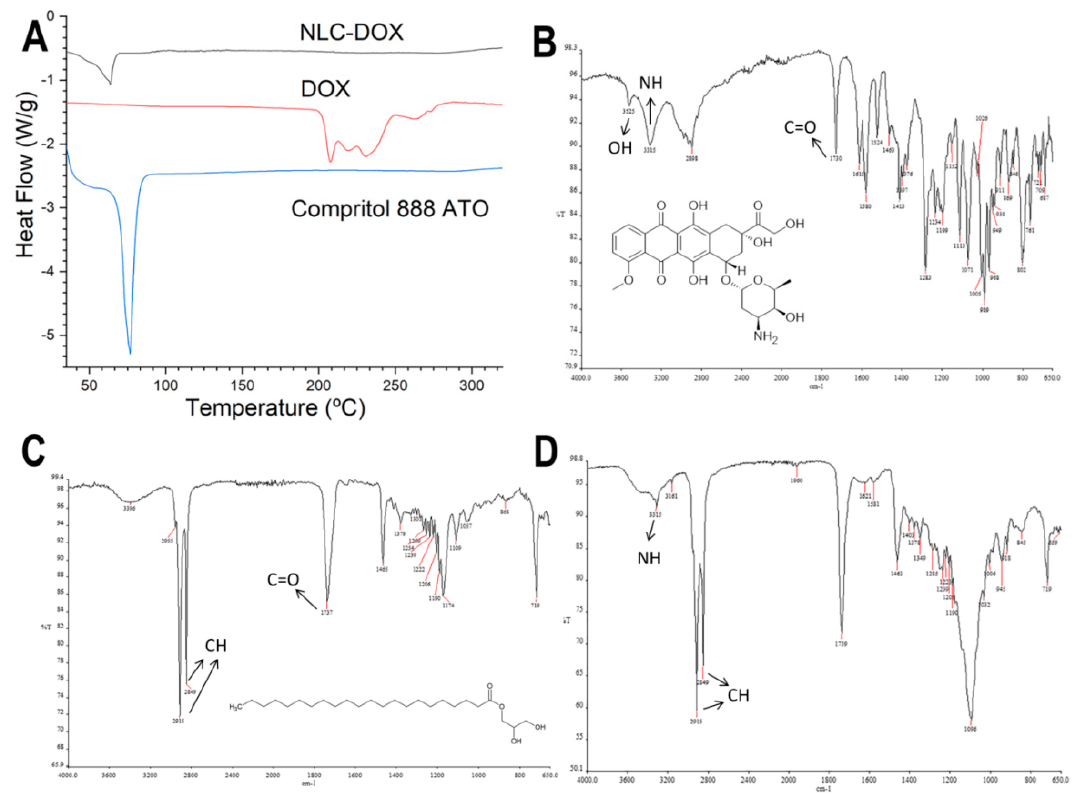
Figure 2. Characterization of the NLC-DOX formulation and its main components by differential scanning calorimetry (DSC) and attenuated total reflection–Fourier transform infrared (ATR-FTIR). DSC curves of NLC-DOX, pure DOX and Compritol 888 ATO ® ( A ); ATR-FTIT spectra of DOX ( B ), Compritol 888 ATO ® ( C ) and NLC-DOX ( D ). The arrows indicate the main absorption regions of the functional groups. Abbreviations: DOX, doxorubicin; NLC, nanostructured lipid